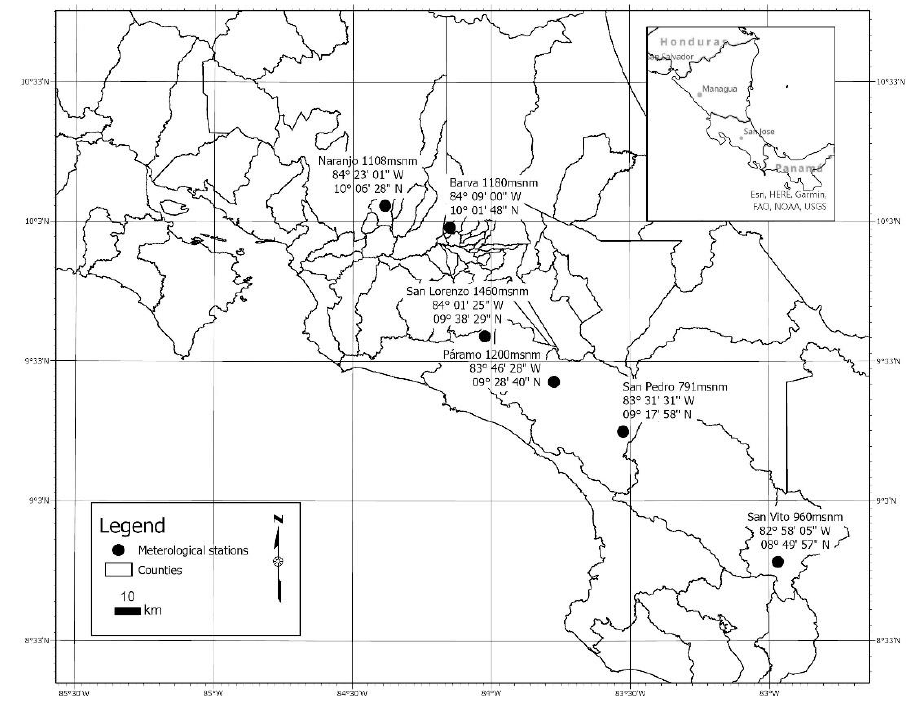
Figure 2. Costa Rica. Regional locations of the meteorological stations and sensors. Leaf wetness was measured at each site using a leaf wetness sensor that detected surface moisture. The sensor was an artificial-leaf electrical-resistance type and consisted of a sensing grid, low-voltage bipolar excitation circuit, and conductivity-sensing circuit [21]. The LWD sensors from the six regions were from the same brand and were installed following the manufacturer’s specifications. The sensors were mounted on a vertical pipe deployed at 1.5 m from the ground and facing west at an angle of 45° to simulate a typical leaf position and to permit run-off of excess moisture. Additionally, the sensors were monitored and maintained by ICAFE to guarantee the quality of the information. All the sensors reported leaf wetness level on a point scale from 0 to 15 at given time intervals. For coffee, agronomists generally consider a leaf to be wet if the sensor indicates a value of 1 or higher at a time